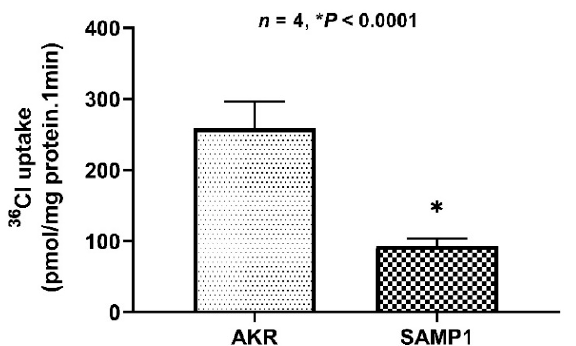
Figure 2. Inhibition of Cl − /HCO 3 − exchange activity in villus cell BBMV of SAMP1 mice. Cl − /HCO 3 − exchange activity ( 36 Cl uptake, pmol/mg protein/min) was significantly inhibited in BBMV prepared from ileal villus cells of SAMP1 mice compared to AKR controls. n = 4, * p < 0.0001.